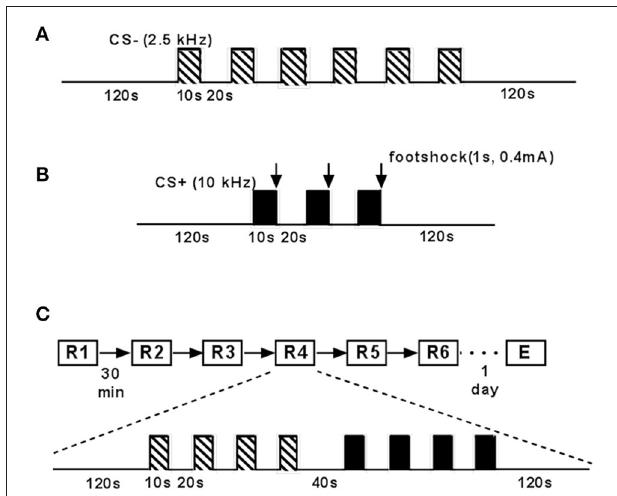
FIGURE 2 | Schematic drawing of experimental paradigm of fear conditioning and extinction. (A) Mice were placed in the fear conditioning chamber (context A) and adapted twice (inter-trial interval: 6h) to a neutral tone (neutral conditioned stimulus, CS − ; 2.5kHz, 85dB). CS − , indicated by striped bars, was presented 6 times for 10s with an interval of 20s. (B) C57BL/6J mice underwent fear conditioning in context (A) . Conditioned stimulus (CS + ; 10kHz, 85 dB, 10s), indicated by black bars, was presented 3 times (interval: 30s) followed by a 0.4mA electrical stimulus (1s) indicated by arrows. This was performed twice with an inter-trial interval of 6h. (C) Animals were placed into the recording chamber (context B). After 120s CS − was presented 4 times (interval: 30s) followed by 4 CS + presentations (interval: 30s) after 40s. This was performed 6 times (extinction training; inter-session interval: 30min). Twenty four hours later fear extinction recall was tested with one final